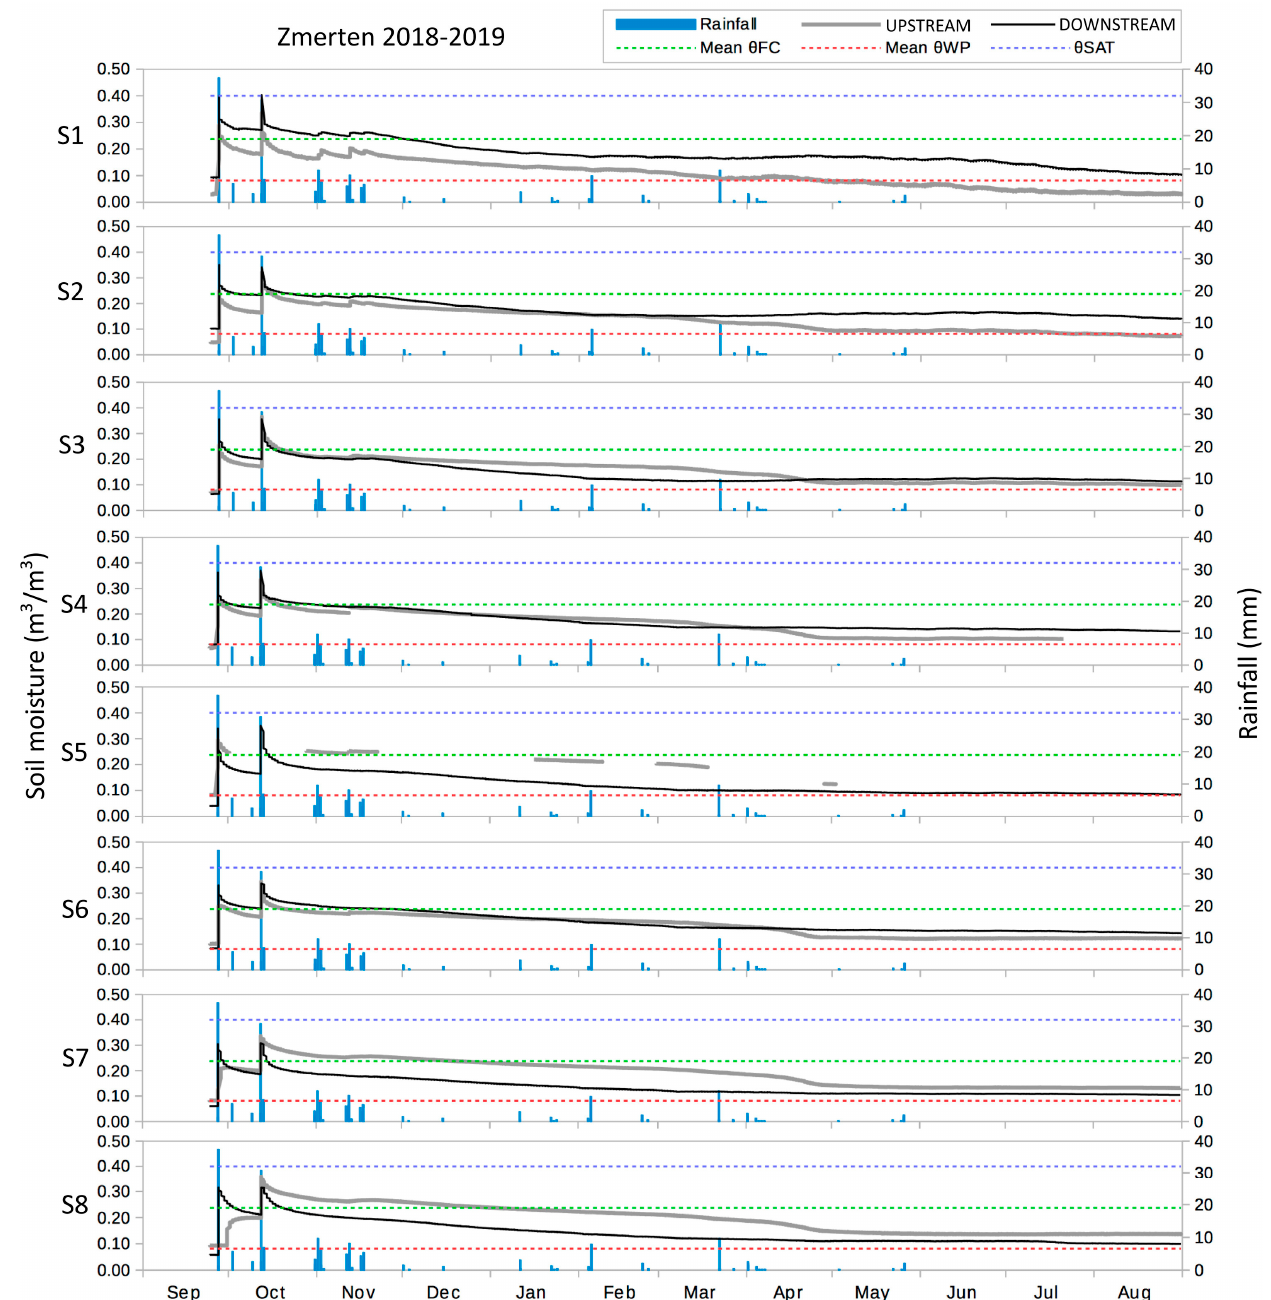
Figure 5. Evolution of soil moisture for the 8 sensors of upstream and downstream Jessour soil pro fi les (2018–19 agricultural year).